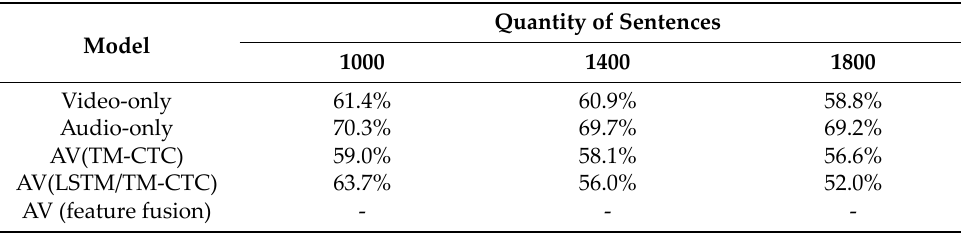
Table 5. CER for different quantities of sentences in video-only, audio-only, and different fusion models.